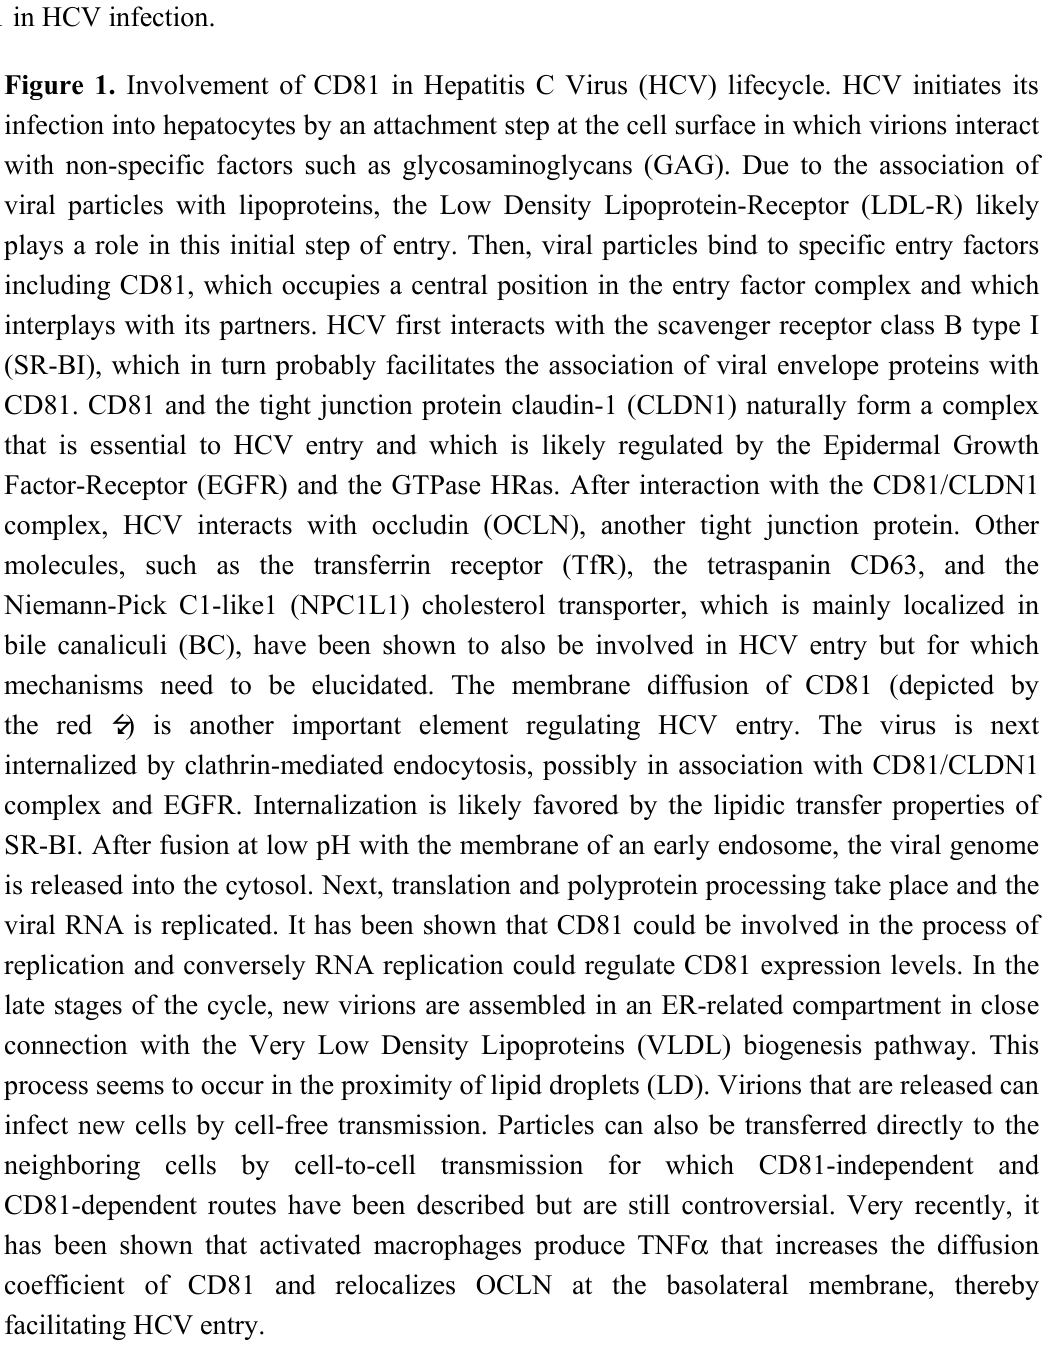
Figure 1. Involvement of CD81 in Hepatitis C Virus (HCV) lifecycle. HCV initiates its infection into hepatocytes by an attachment step at the cell surface in which virions interact with non-specific factors such as glycosaminoglycans (GAG). Due to the association of viral particles with lipoproteins, the Low Density Lipoprotein-Receptor (LDL-R) likely plays a role in this initial step of entry. Then, viral particles bind to specific entry factors including CD81, which occupies a central position in the entry factor complex and which interplays with its partners. HCV first interacts with the scavenger receptor class B type I (SR-BI), which in turn probably facilitates the association of viral envelope proteins with CD81. CD81 and the tight junction protein claudin-1 (CLDN1) naturally form a complex that is essential to HCV entry and which is likely regulated by the Epidermal Growth Factor-Receptor (EGFR) and the GTPase HRas. After interaction with the CD81/CLDN1 complex, HCV interacts with occludin (OCLN), another tight junction protein. Other molecules, such as the transferrin receptor (TfR), the tetraspanin CD63, and the Niemann-Pick C1-like1 (NPC1L1) cholesterol transporter, which is mainly localized in bile canaliculi (BC), have been shown to also be involved in HCV entry but for which mechanisms need to be elucidated. The membrane diffusion of CD81 (depicted by the red  ) is another important element regulating HCV entry. The virus is next internalized by clathrin-mediated endocytosis, possibly in association with CD81/CLDN1 complex and EGFR. Internalization is likely favored by the lipidic transfer properties of SR-BI. After fusion at low pH with the membrane of an early endosome, the viral genome is released into the cytosol. Next, translation and polyprotein processing take place and the viral RNA is replicated. It has been shown that CD81 could be involved in the process of replication and conversely RNA replication could regulate CD81 expression levels. In